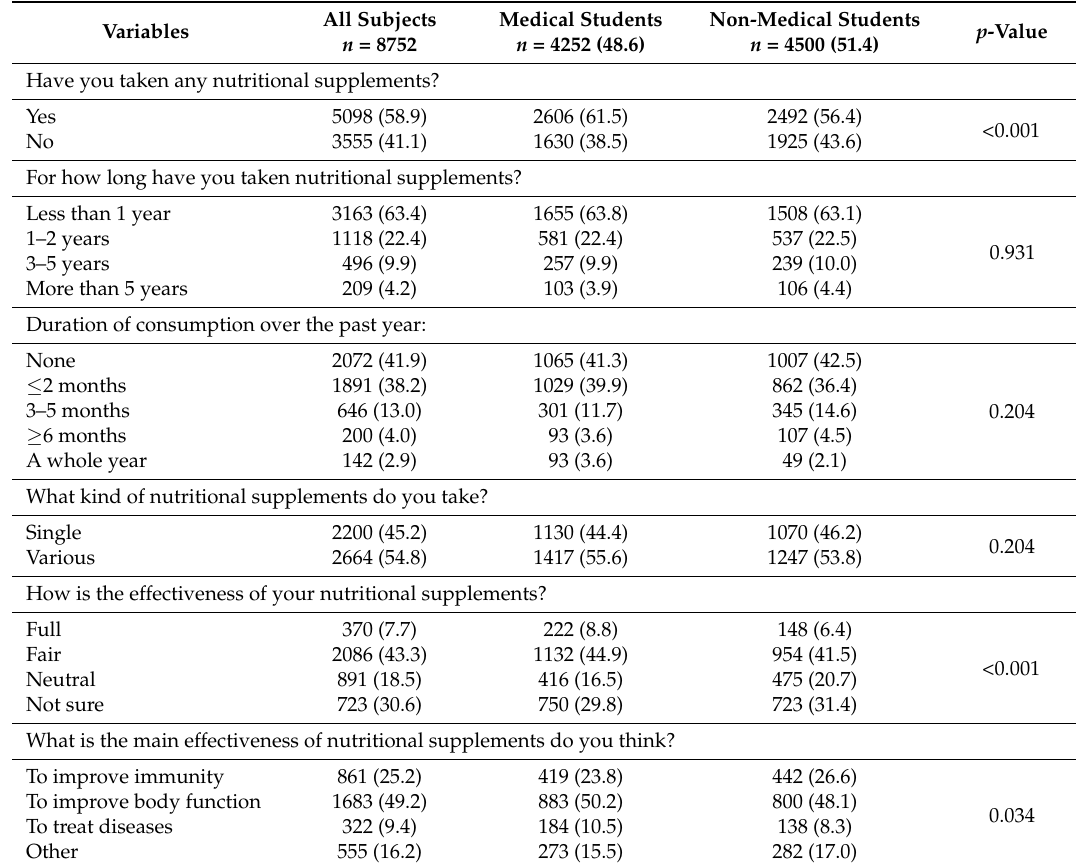
Table 3. Nutritional supplements consumption behavior